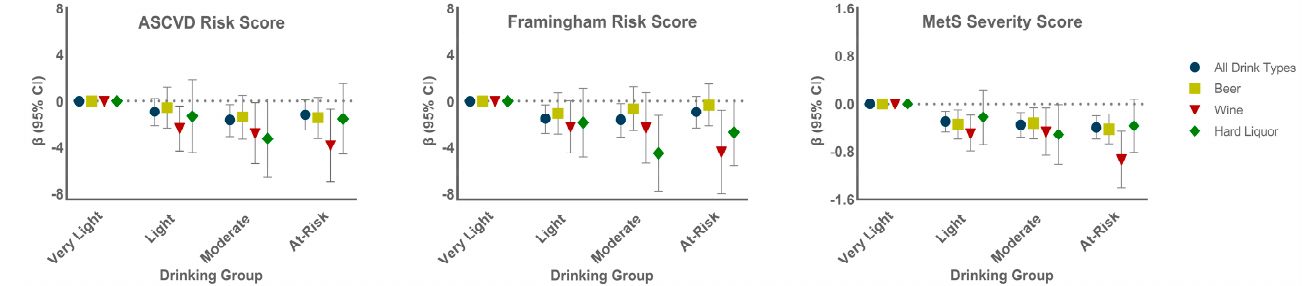
Figure 3. β values (95% CI) by drinking group and drinking type preference, comparing all groups to the very light drinking group, for all three CVD risk scores. Results of the base model are shown.